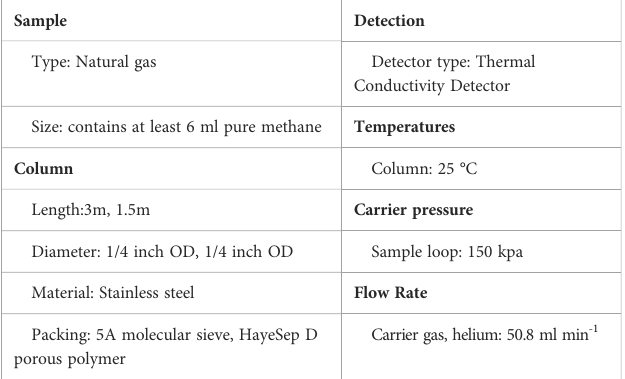
TABLE 1 Chromatography conditions on puri fi cation